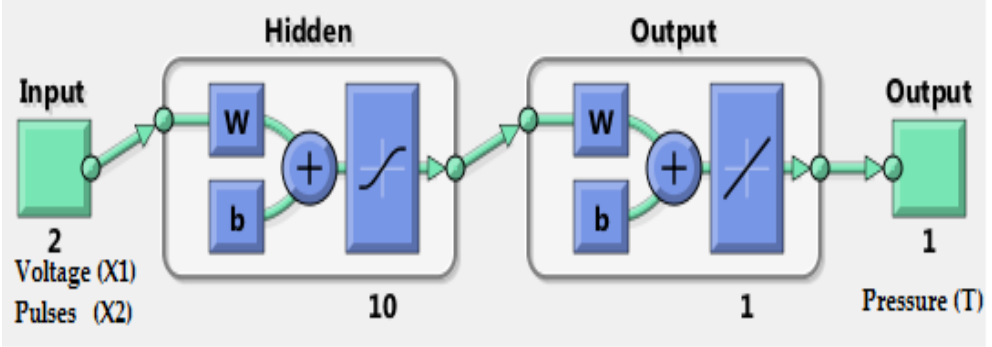
Figure 5. Two-layer feedforward network with a sigmoid transfer function in the hidden layer and a linear transfer function in the output layer.